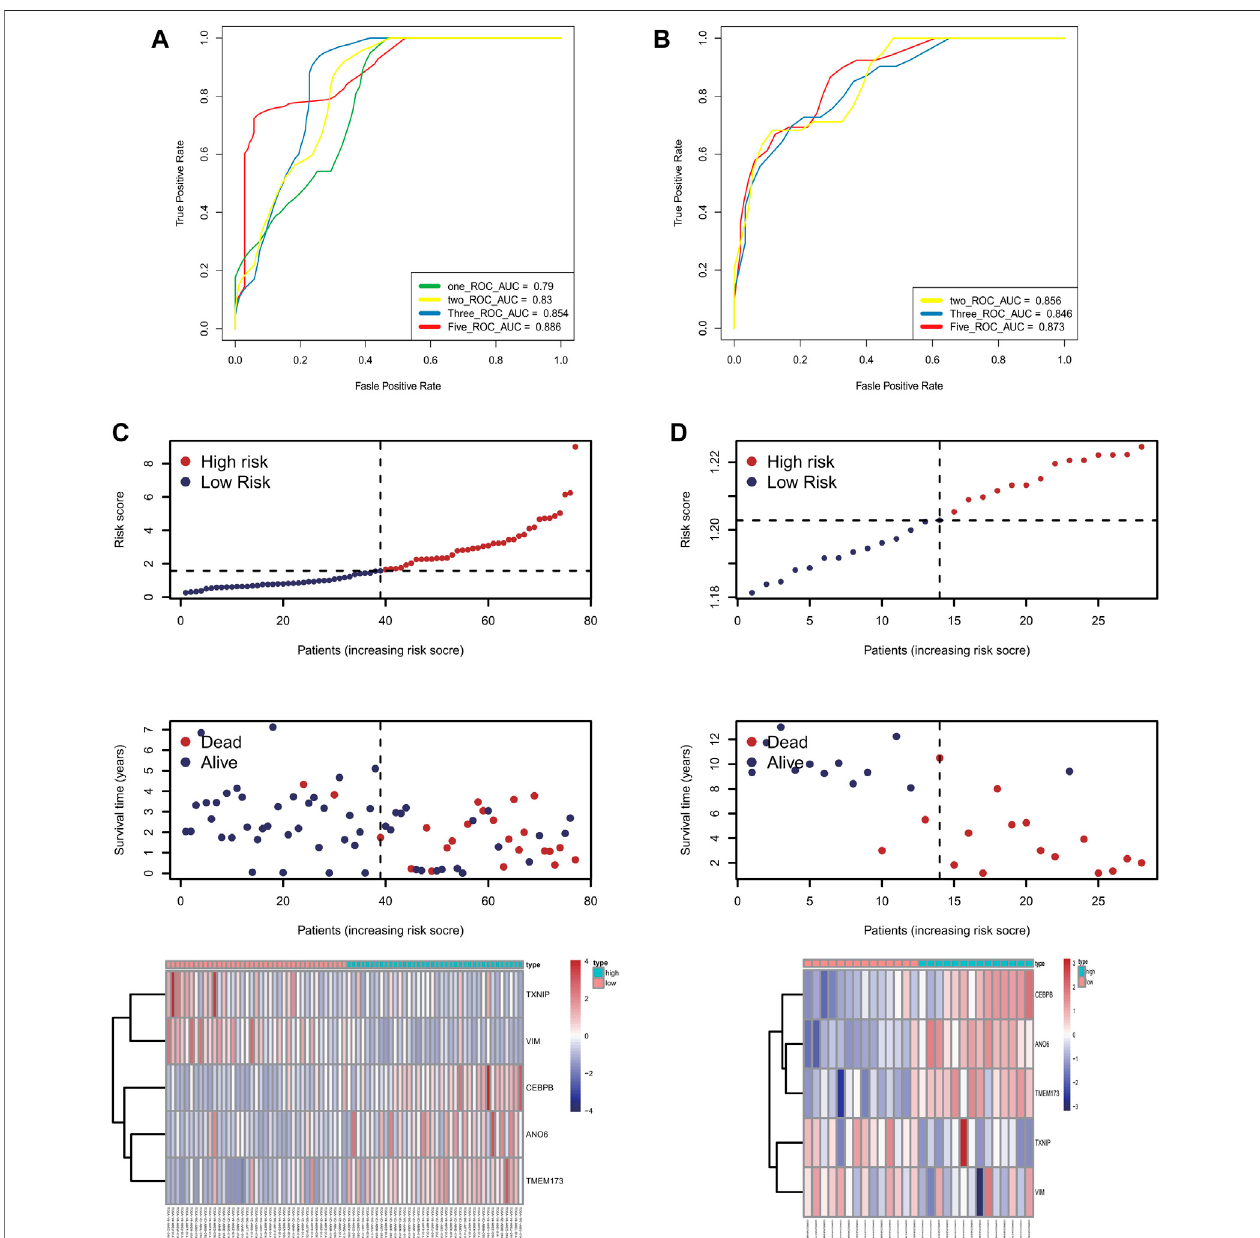
FIGURE 4 | The accuracy of this prognostic model. (A,B) The ROC curve of patient ’ s survival of different years in the training cohort and the validation cohort showed that the model had a potent predicting ability, with the 1-year, 2-years, 3-years and 5-years AUC being 0.79, 0.83, 0.854, 0.886 respectively in the training cohort (Panel 4A), and the 2-years, 3-years and 5-years AUC being 0.856, 0.846, 0.873 respectively in the validation cohort (Panel 4B). ( C,D ) The distribution of the risk scores, outcome status, and gene pro fi les of the gene signature in the training and validation cohort were shown. The risk group successfully predicted the outcomes of the patients in both the training cohort and the validation cohort, with signi fi cantly more events found in the high-risk group. Moreover, the expression of genes ANO6, CEBPB and TMEM173 were upregulated, while genes VIM, TXNIP were seen downregulated in the high-risk group both in the training cohort and in the validation cohort, which was in accordance with our previous risk